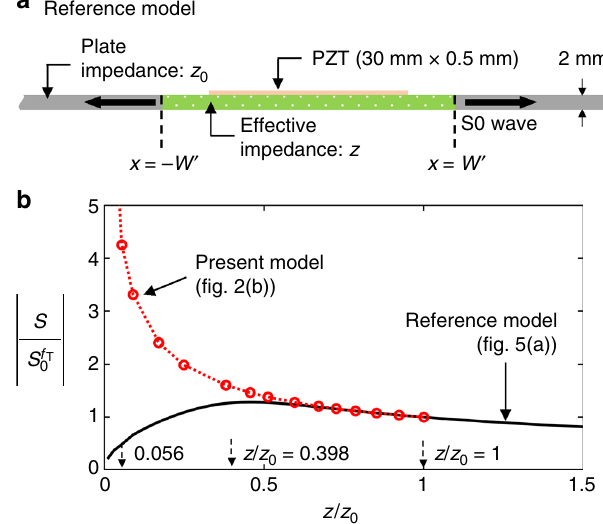
Fig. 5 Comparison between zero-impedance concept and impedance matching concept. a Reference model to investigate the effects of impedance matching. It consists of a plate of nominal impedance z 0 and a PZT patch of impedance z PZT = 0.398 z 0 bonded onto the plate segment between x = − W ′ and x = W ′ having varying impedance z . b The comparison of the radiated strain fi eld | S | at f = f T = 71.7 kHz NATURE COMMUNICATIONS| (2018) 9:5255